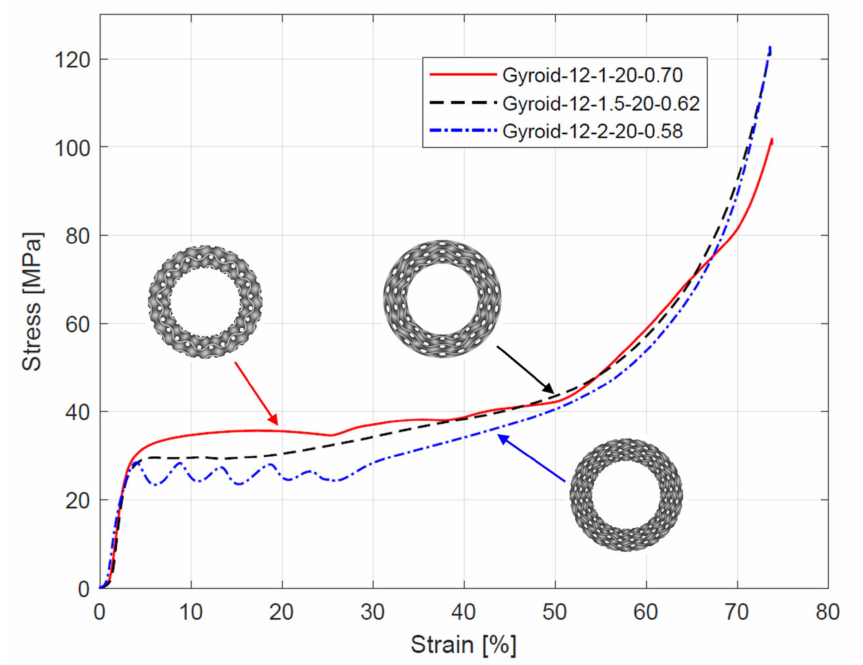
Figure 7. Stress–strain curves from compressive testing of cylindrically mapped gyroid structures with 12 unit cells in a circumferential direction.